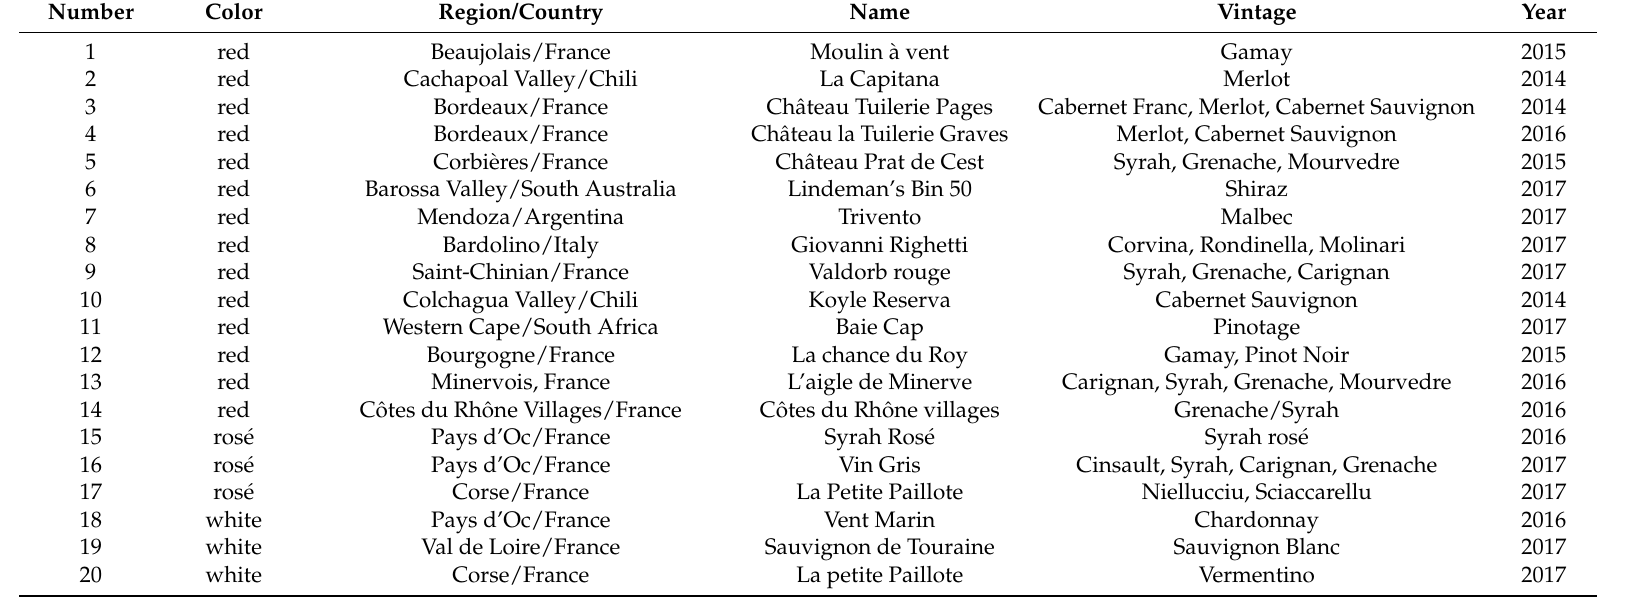
Table 1. Characteristics of tested wines bought in a Belgian commercial